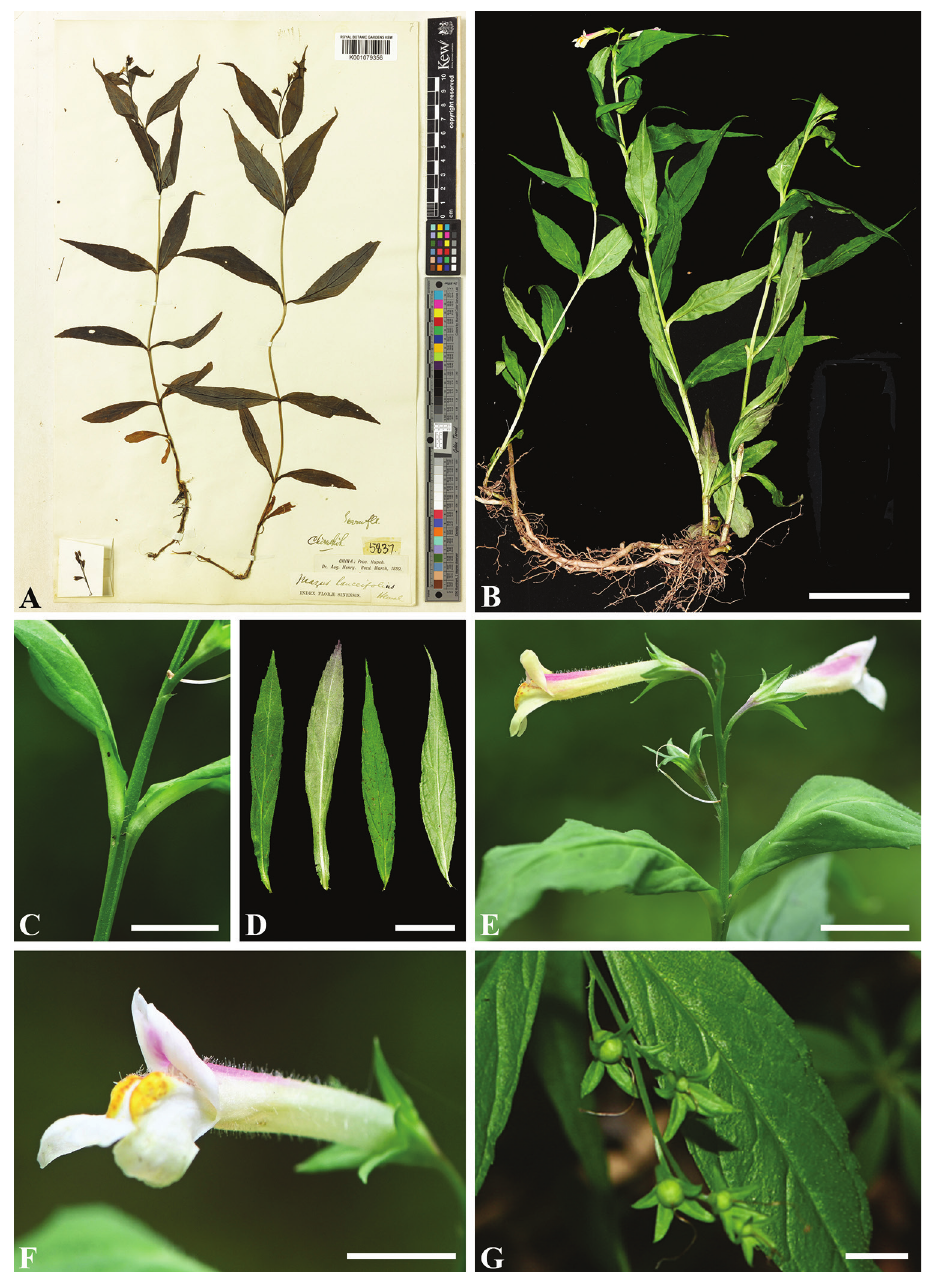
Figure 1. Puchiumazus lanceifolius ( ≡ Mazus lanceifolius ) A lectotype deposited at K ( A. Henry 5837 , barcode K001079356) B habit C stem, showing the obtuse ribs D leaves E inflorescence F flower in lat- eral review G young fruits. Scale bars: 5 cm ( B ); 0.5 cm ( C, F, G ); 2 cm ( D ); 1 cm ( E